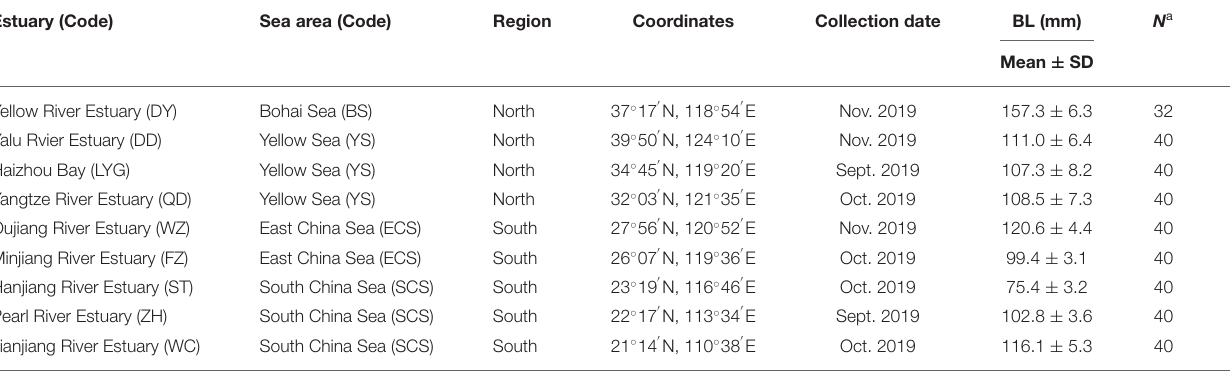
TABLE 1 | Sampling information of spinyhead croaker Collichthys lucidus from Chinese coastal waters. Estuary